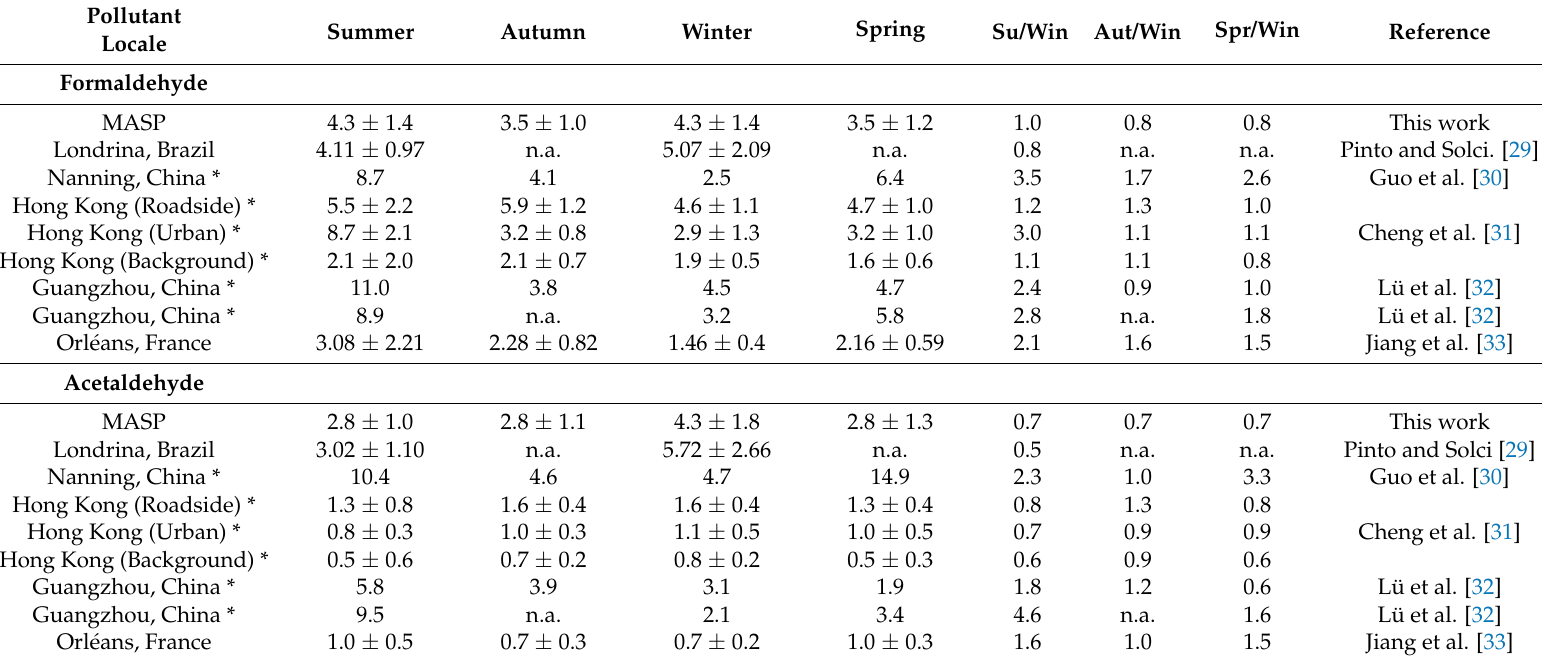
Table 3. Seasonal comparison of formaldehyde and acetaldehyde mean concentrations (in ppbv), together with the ratios between the seasons, in the Metropolitan Area of S ã o Paulo and in other regions